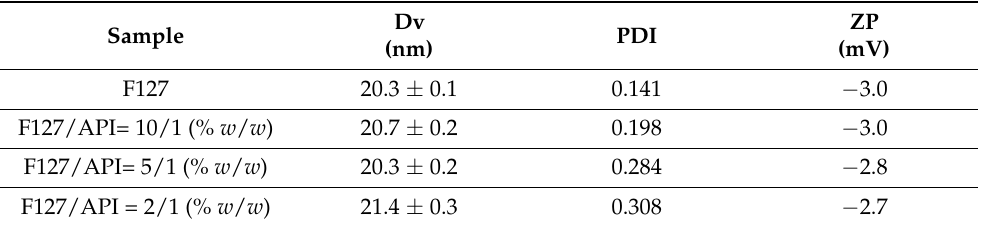
Table 1. Diameter in volume (Dv), polydispersity index (PDI) and zeta potential (ZP) values of free and API-loaded PMs.